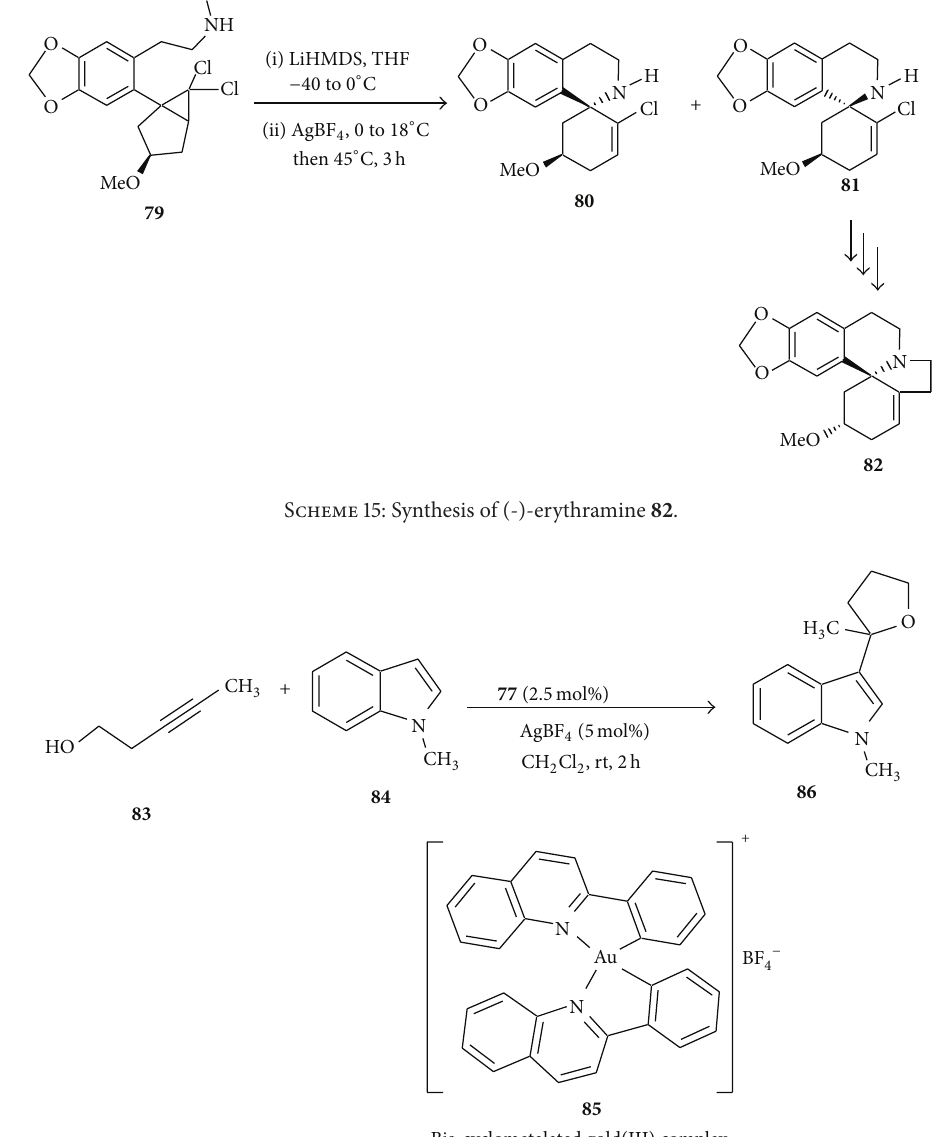
Scheme 16: Gold(III) complex silver-catalyzed cyclization-addition reactions of alkynyl alcohols 83 and substituted indoles 84